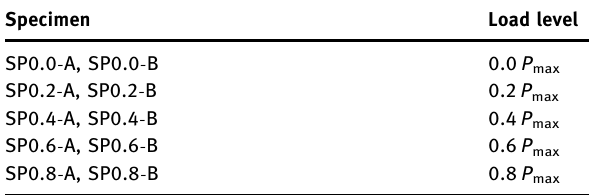
Table 2: Design of test beams